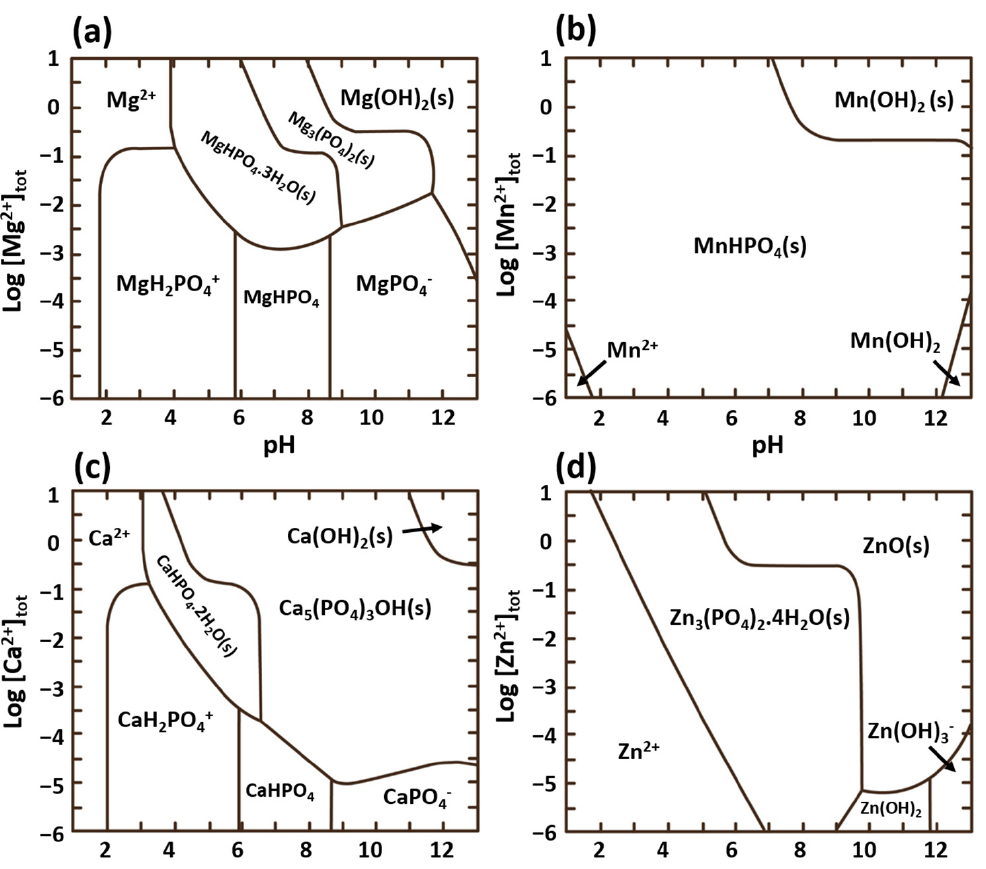
Figure 9 . Predominance area diagrams for solutions containing 0.1 M phosphate as the function of concentrations of ( a ) Mg 2+ , ( b ) Mn 2+ , ( c ) Ca 2+ , and ( d ) Zn 2+ ions and solution pH. Hydra-Medusa software was used to simulate the predominance area. This figure is inspired by [124].